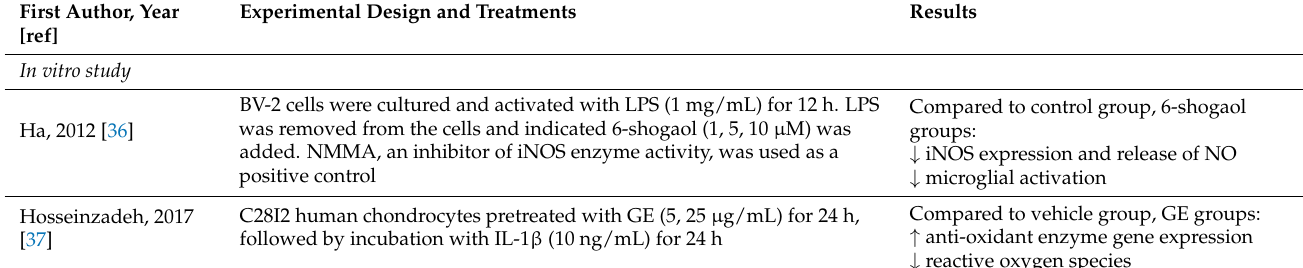
Table 2. Effects of ginger on fibromyalgia-like